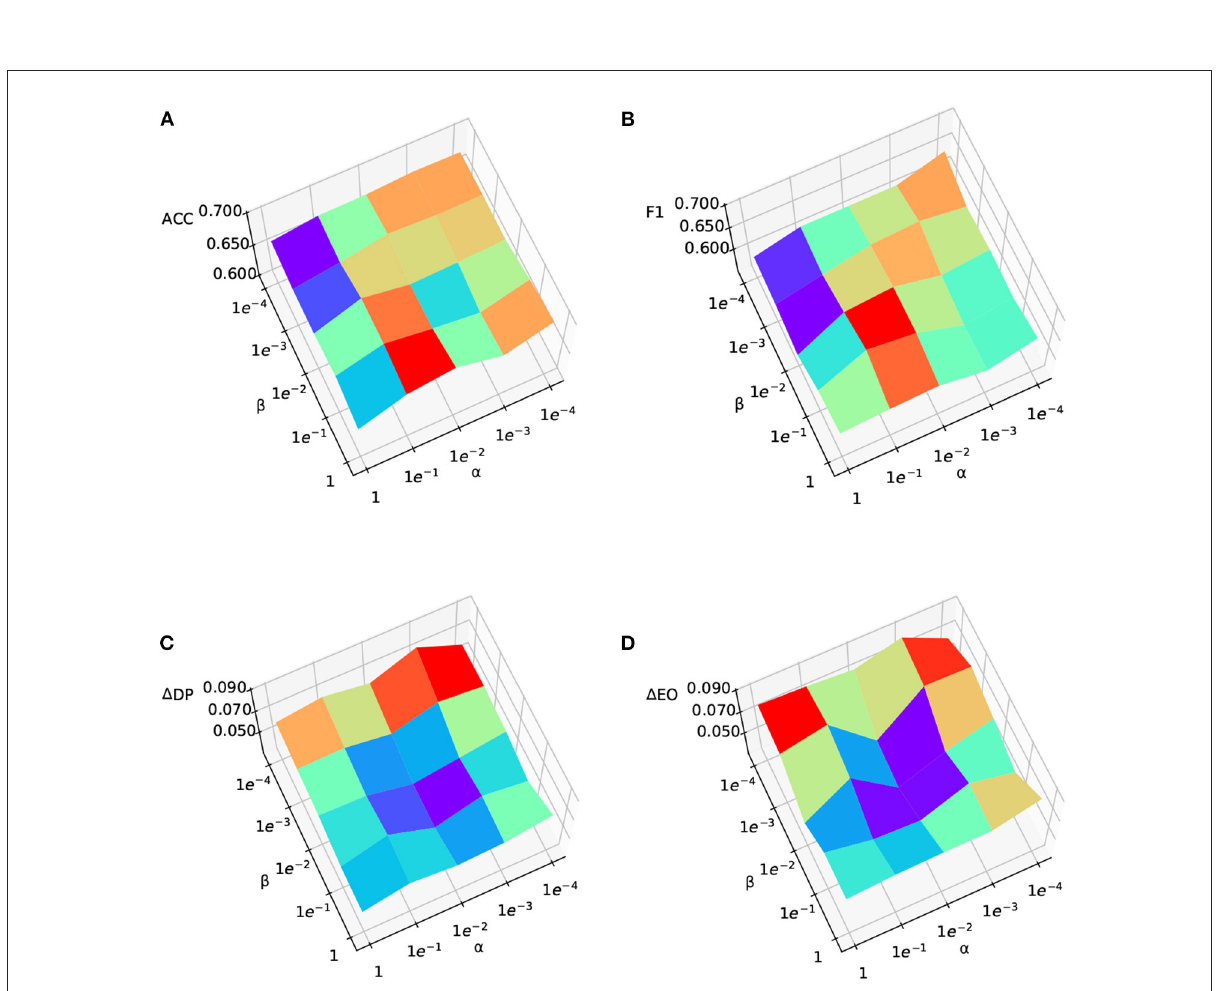
FIGURE3 Parameter sensitivity analysis to assess the impact of domain adversary and debiasing adversary components. (A) ACC, (B) F1, (C) 1 DP , and (D) 1 EO